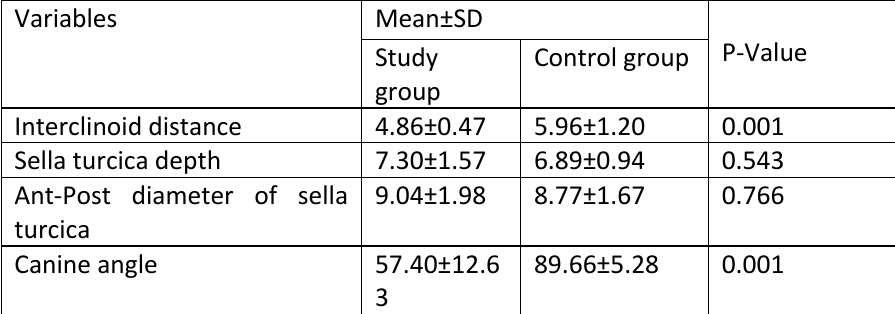
Table 3: Measures of Sella turcica morphologic characteristics in two